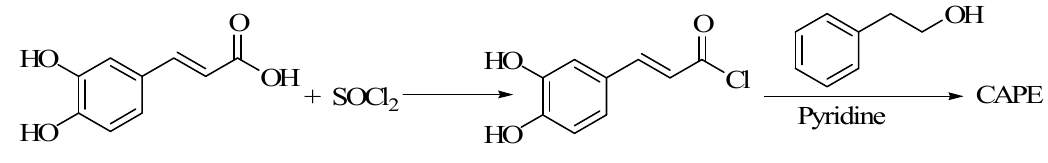
Figure 3. The scheme of method of acyl